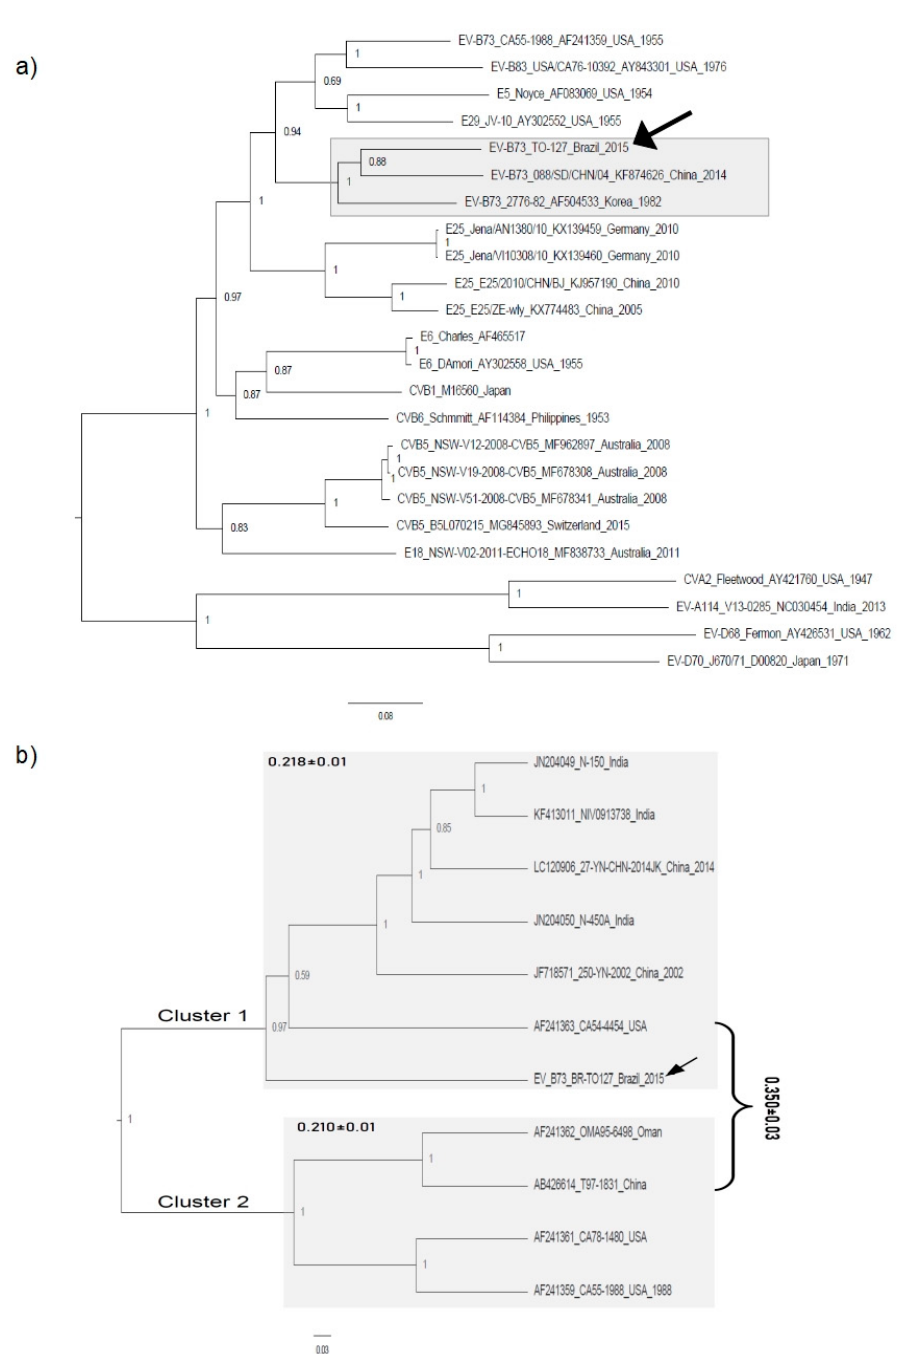
Figure 1. Phylogenetic trees of enterovirus B73. A phylogenetic tree based on the nearly complete genome constructed using sequences based on the best hits of BLASTn searches is shown in ( a ). A phylogenetic tree based on the VP1 region constructed using partial sequences of the coding region of the vp1 gene of B73 isolates in shown in ( b ). The Brazilian strain TO-127 is indicated by filled arrows and the clade it is located in is indicated by gray areas. The vertical scale-bar colors indicate the branch support represented by the approximate likelihood ratio test (aLRT) and the scale bar under the tree represents the nucleotide substitution per site.